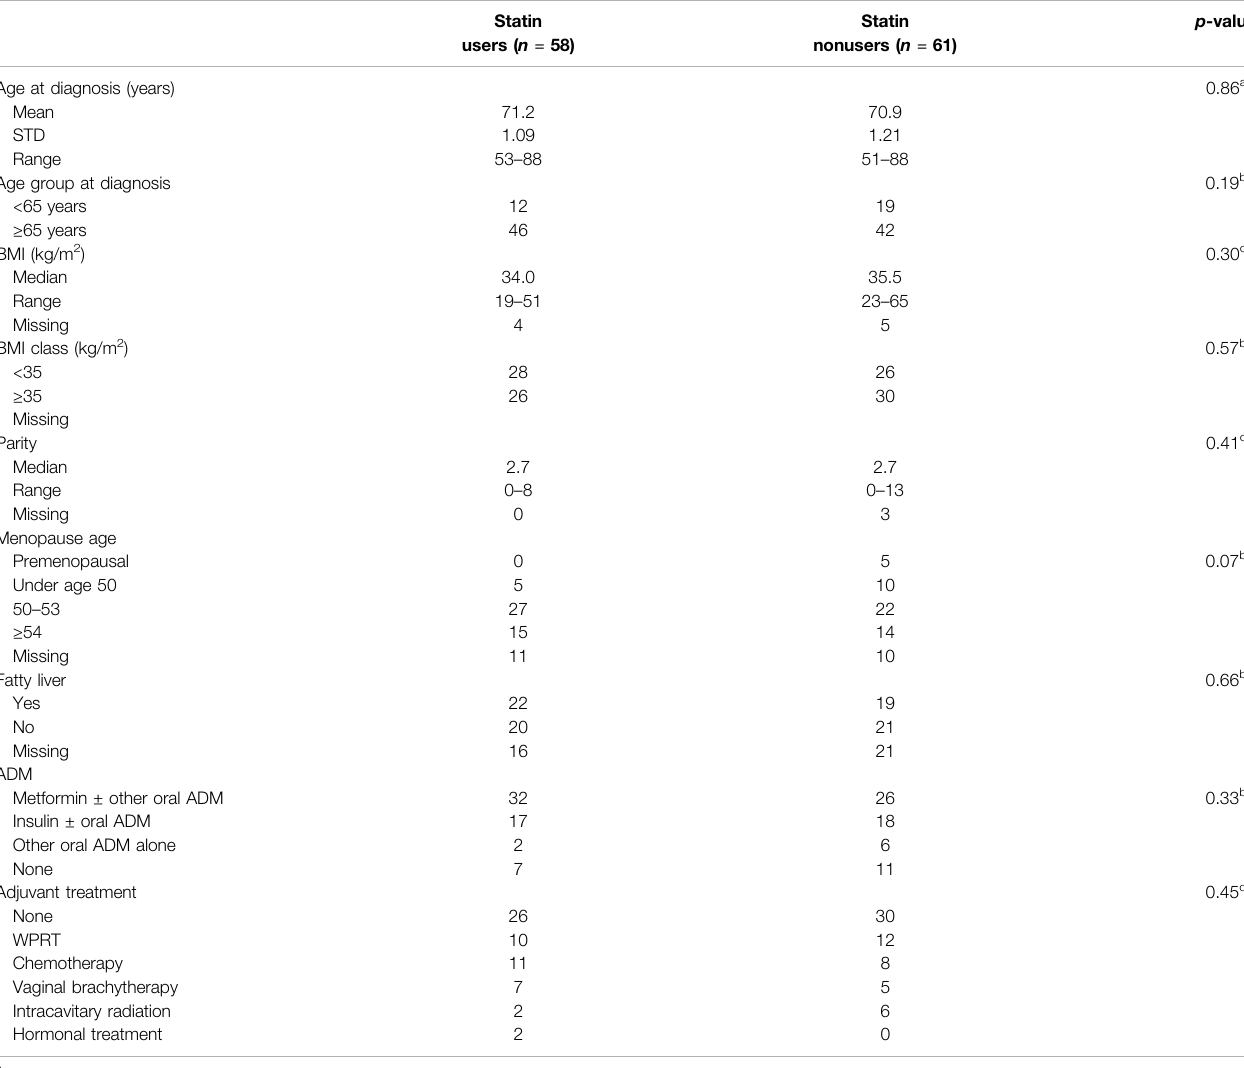
TABLE 1 | Patient characteristics in statin users and